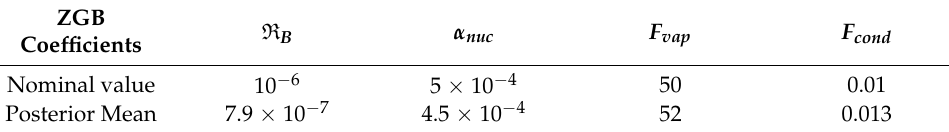
Figure 4. Prior and posterior distributions of the ZGB coefficients. ( a ) bubble diameter, ( b ) nucleation site volume fraction, ( c ) evaporation coefficient, ( d ) condensation coefficient. Table 9. Posterior mean values of model coefficients .